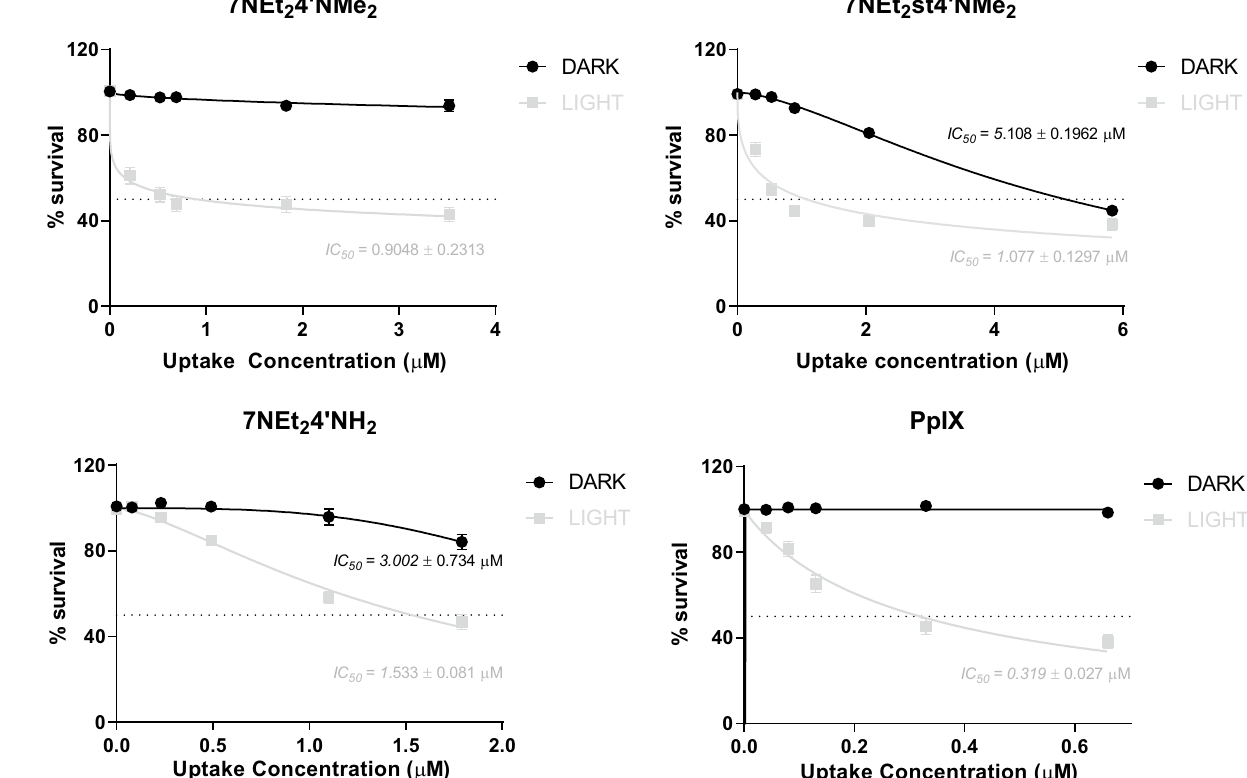
Figure 5. HaCaT cells survival in the presence of the most promising compounds upon irradiation with white light (6.6 J cm −2 ) or maintained in the dark. As a control for the experiment, protoporphyrin IX (PpIX) was used. The results are presented as the logarithmic function of the different tested concentrations. Each value represents the mean ± SEM (n =